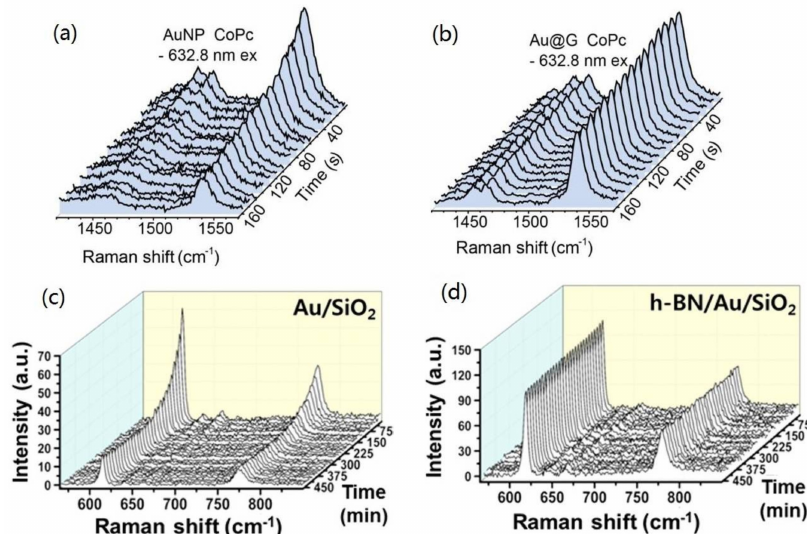
Figure 10. Stability of SERS signals of monolayer CoPc LB films on ( a ) Au and ( b ) Au@G. Reproduced from [65] with permission; Copyright ACS 2014. Photothermal and chemical stability of 3 L h-BN/Au/SiO2 substrate; SERS spectra of R6G on the Au/SiO2 substrate ( c ) without and ( d ) with h-BN protection at different time points (laser power = 0.1 mW, time interval = 15 min). Reproduced from [74] with permission; Copyright ACS